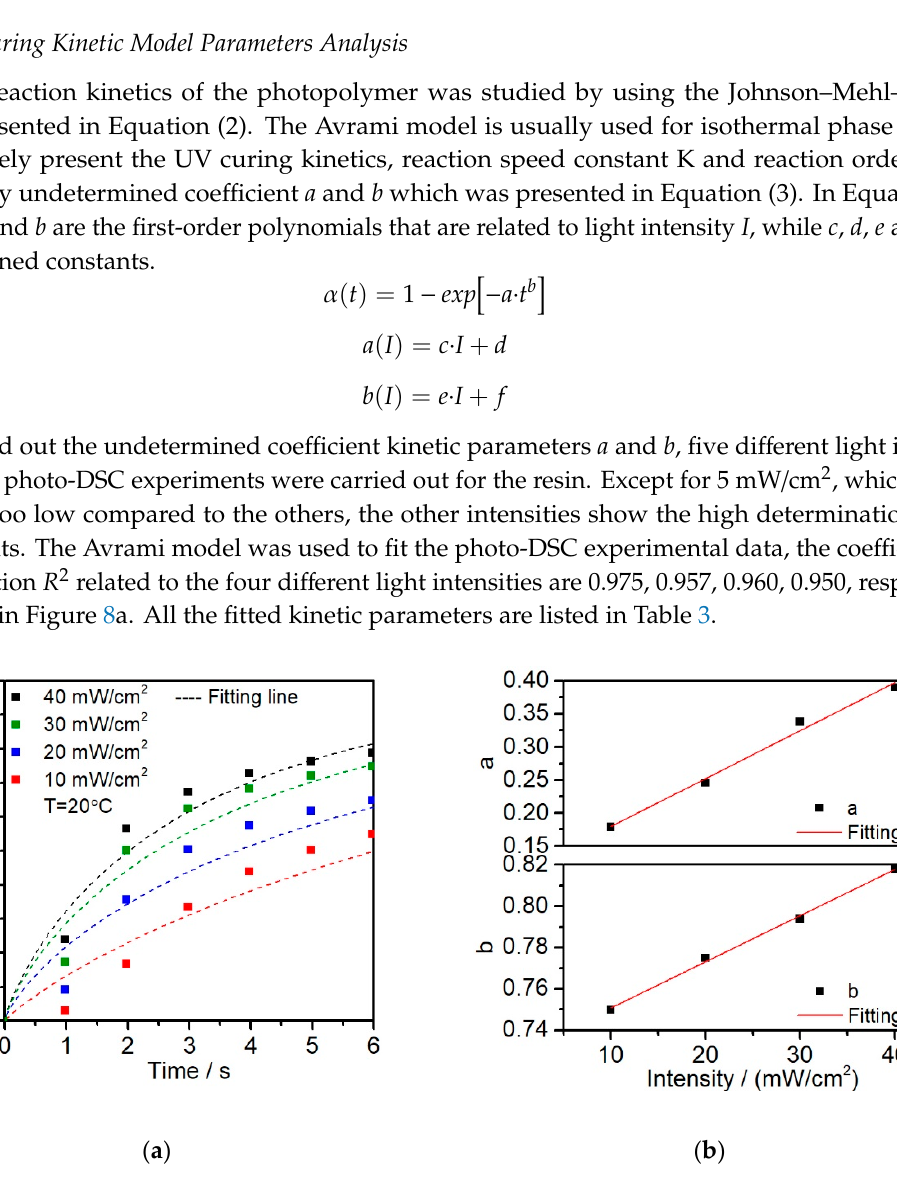
Figure 8. ( a ) Curing degree with different light intensity and related fitting curves by modified Avrami model; ( b ) experiment points and fitting line of undetermined coefficients a and b . Table 3. Parameters used in the modified Avrami model Equation